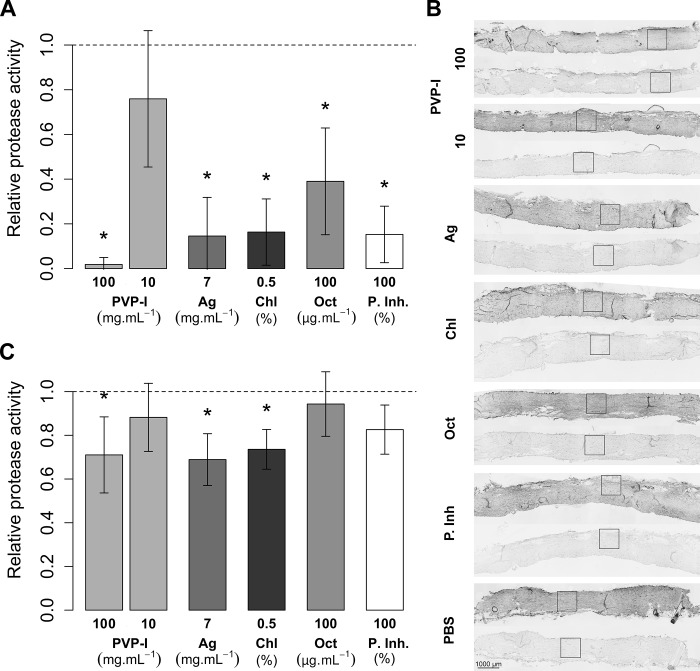
Activity of porcine skin endogenous proteases with antimicrobials.Whole skin was incubated with the tested compounds in a tube, homogenized, and assessed by means of gelatin zymography (A) or incubated in Franz diffusion cells (dermal side up) and analysed using in situ zymography, as illustrated with representative images (B). Color-inverted images, darker shades correspond to increased proteolysis. Each sample was developed with fluorogenic substrate either at 37°C (the upper sample section of each treatment) or at -20°C (assay control, the lower sample section). Squares show areas of fluorescence intensity measurement, which were evaluated in replicates (n = 5) with image analysis (C). Bars in (A) and (C) show mean protease activity related to PBS control ± SD. * denotes p < 0.05 (Student's one sample t-test to control). The tested compounds were povidone-iodine (PVP-I), silver lactate (Ag), chlorhexidine digluconate (Chl), octenidine hydrochloride (Oct), commercial protease inhibitors (P. Inh.).